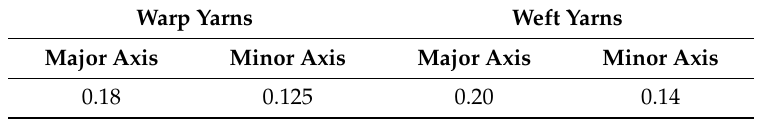
Table 4. Average values (in mm) of the major and minor axis of the yarn sections (P2-8